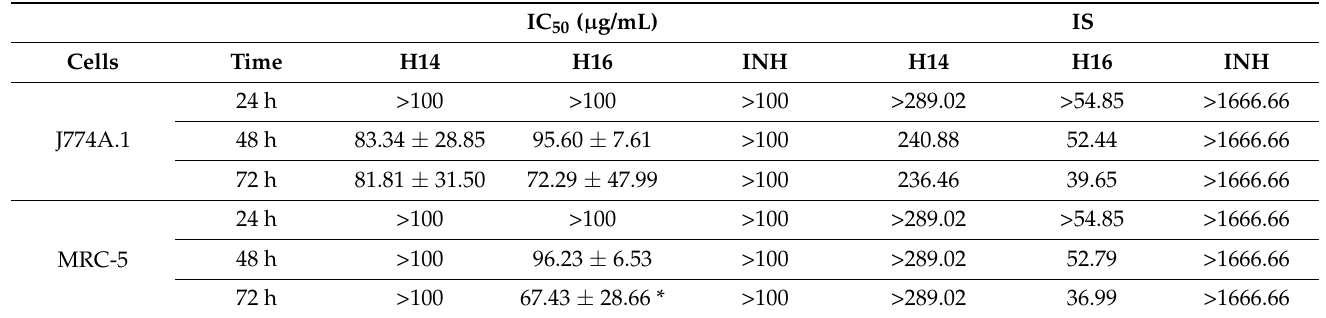
Table 2. Inhibitory concentration (IC 50 ) and selectivity index (SI) of hydrazones 14, 16, and isoniazid against macrophages (J774A.1) and lung fibroblasts (MRC-5) at 24, 48, and 72 h. IC 50 ( µ g/mL)